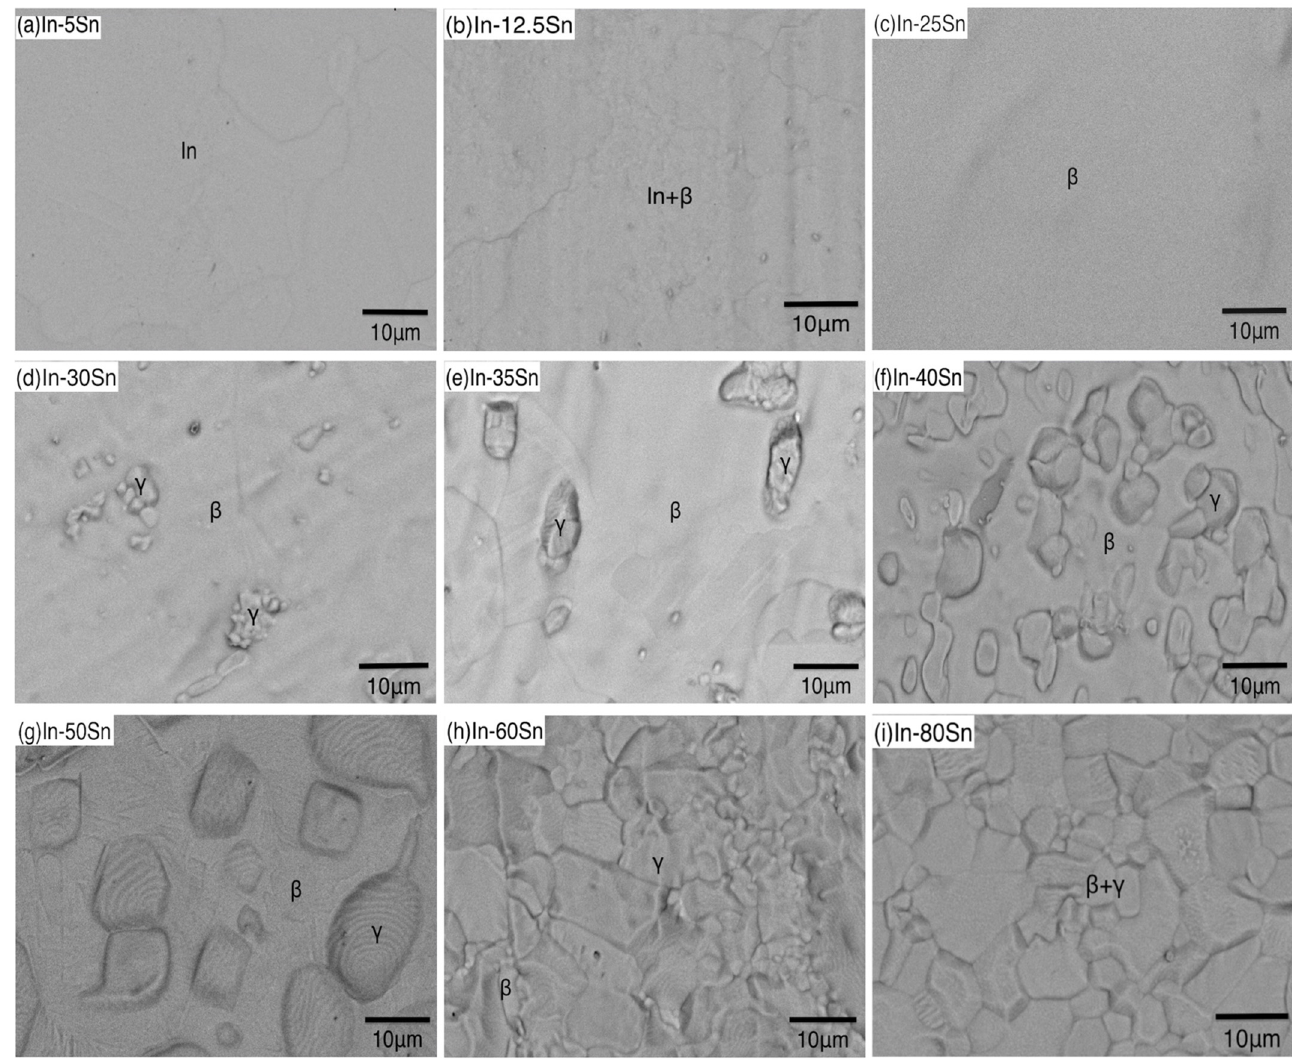
Figure 7. Microstructure of In-Sn alloys with increasing of tin content from ( a – i ).